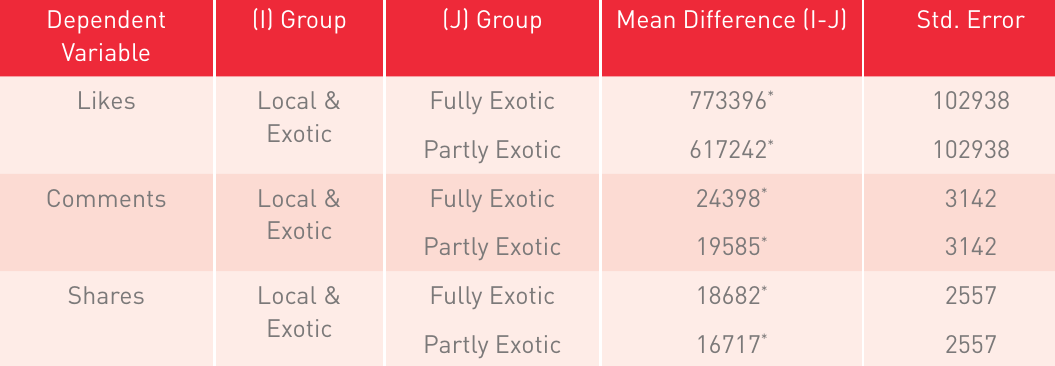
Corresponding engagement responses of digital cosmopolitans Dependent Variable